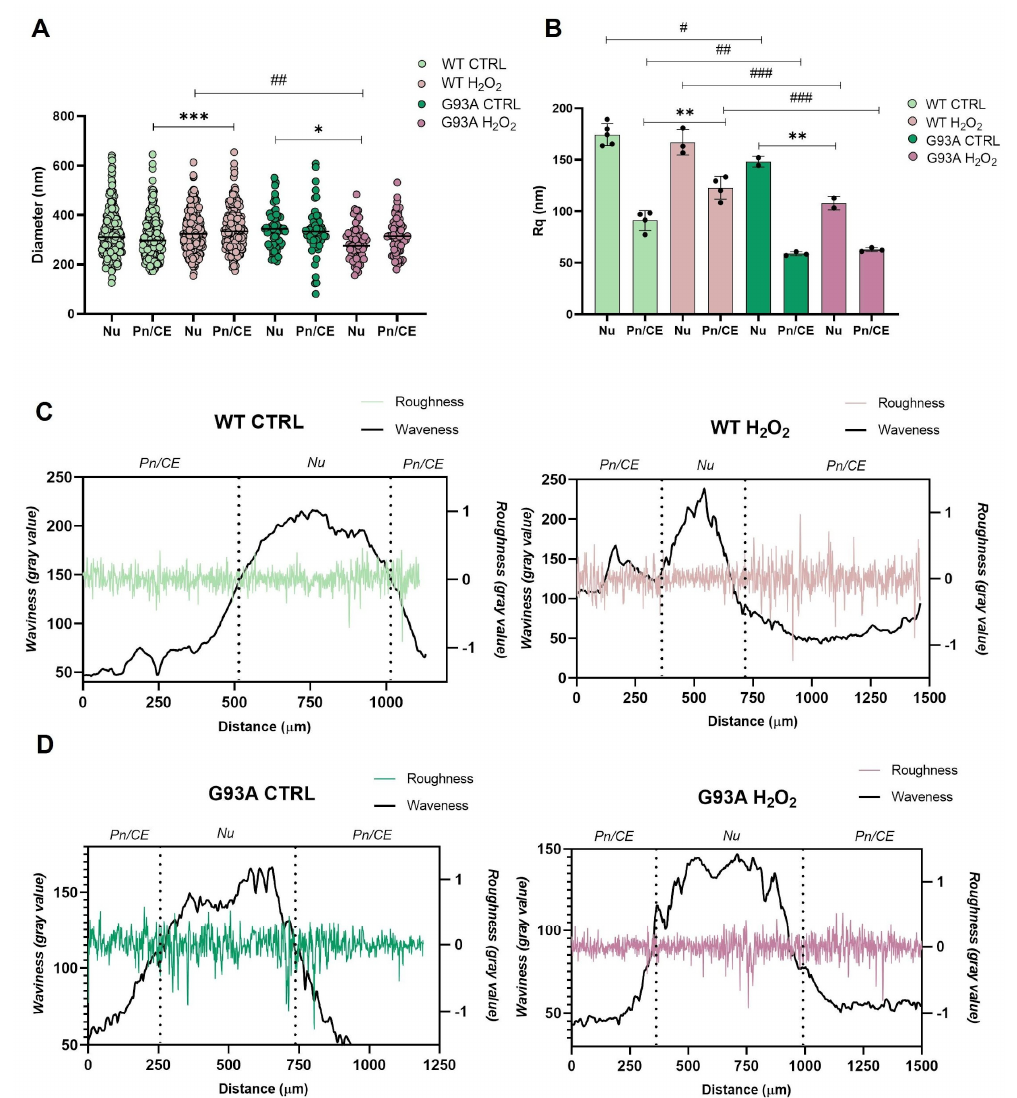
Figure 6. ( A ) Direct comparison of the median diameters of budding vesicles of mapped regions (3 × 3 µ m 2 ) from CTRL (Nu = 310.0 nm; Pn/CE = 297.4) and H 2 O 2 -treated (Nu = 323.6 nm; Pn/CE = 334.0 nm) WT and CTRL (Nu = 343.8 nm; Pn/CE = 333.2 nm) and H 2 O 2 -treated (Nu = 275.4 nm; Pn/CE = 314.5 nm) SOD1-G93A SH-SY5Y performed by AFM. ( B ) Rq measurements of mapped regions of all the experimental groups. Values represent the mean ± SD; statistical analysis was carried out using one-way ANOVA with Tukey’s multiple comparisons test. * p < 0.05, ** p < 0.01 and *** p < 0.001, when compared with the control group; # p < 0.05, ## p < 0.01 and ### p < 0.001, when compared between WT and G93A groups. ( C , D ) Roughness and waviness (gray values) measurements performed on all the experimental groups (upper panels for WT cells, lower panels for SOD1-G93A cells). Vertical dotted lines separate nuclear from peripheral regions. Nu = nuclear zone; Pn/CE = perinuclear-to-cellular edge regions.